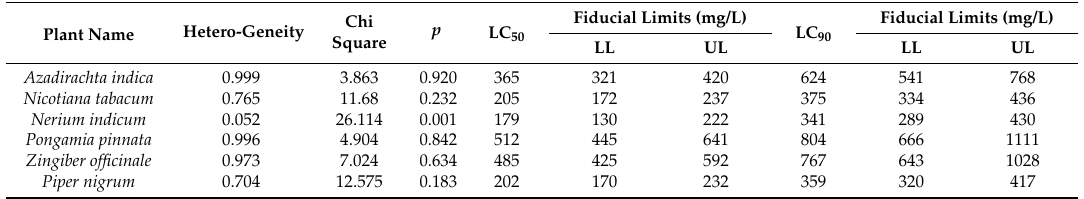
Table 4. Summary of probit analysis on the mortality data of six different plant extracts on P. maculata.